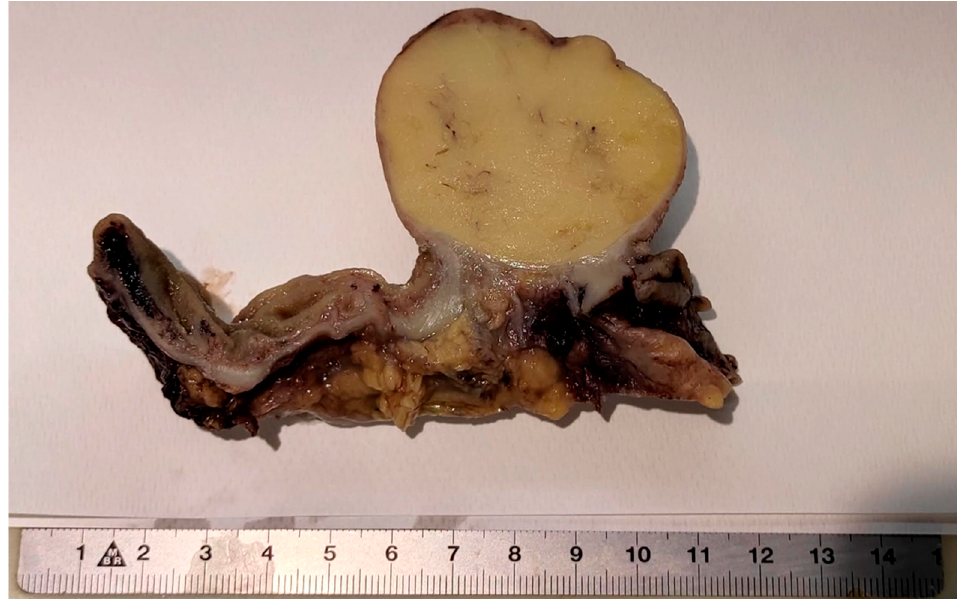
Figure 5. A large well-circumscribed soft mass in the colonic wall. Cut surface is bright yellow and uniform.